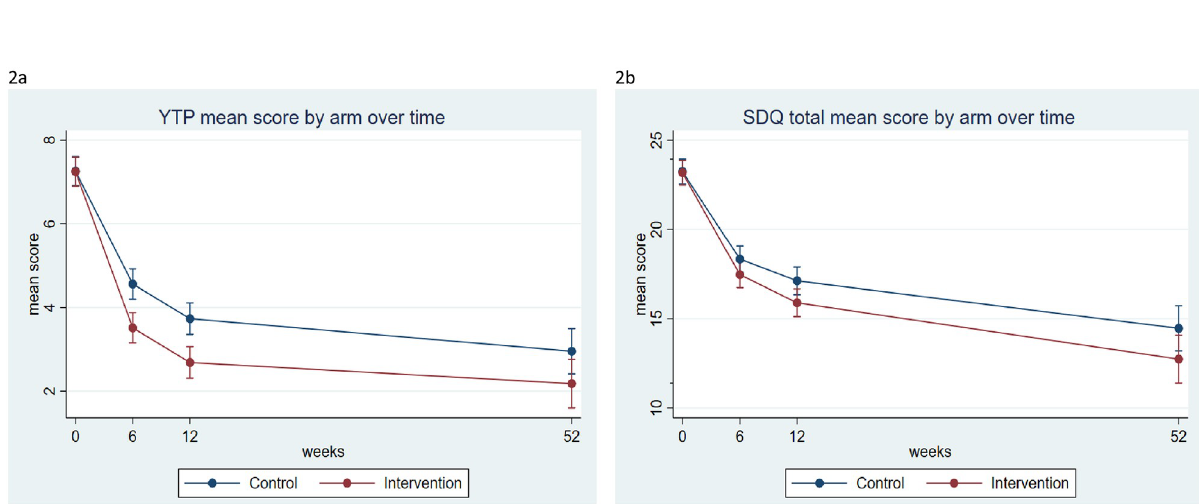
Fig 2. Primary outcomes over time according to arm. (a) M YTP score. Error bars indicate 95% CIs. (b) M SDQ Total Difficulties score. Error bars indicate 95% CIs. CI, confidence interval; M, Mean; SDQ, Strengths and Difficulties Questionnaire; YTP, Youth Top